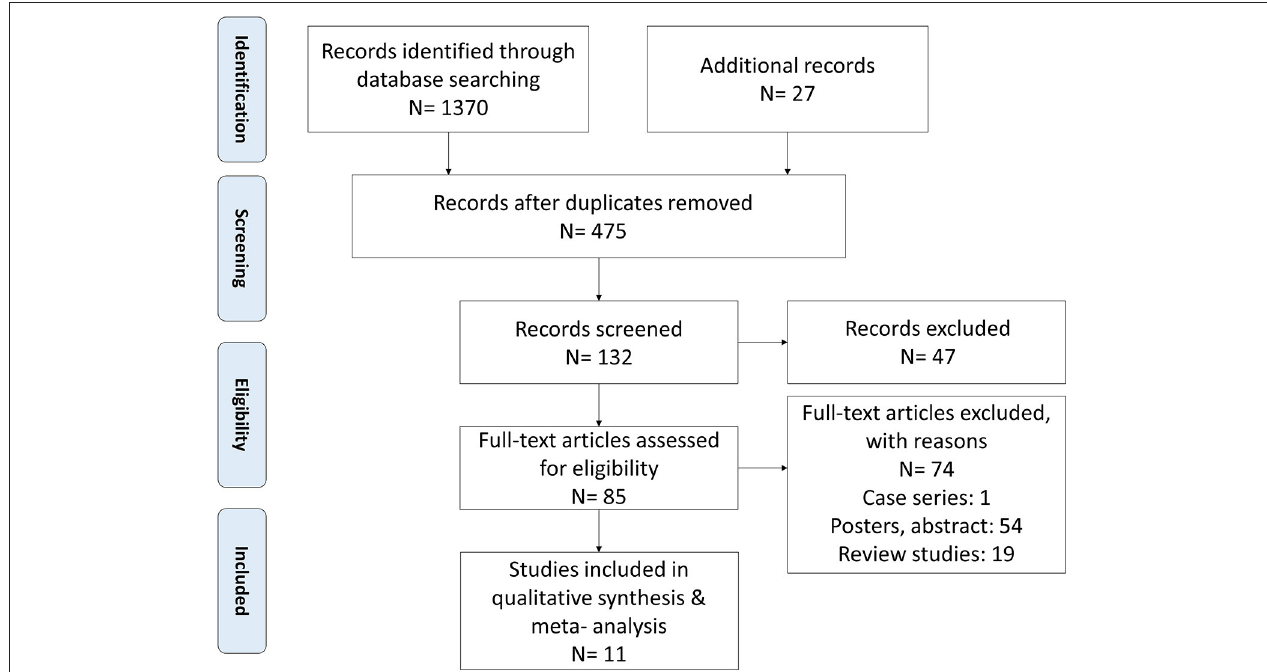
FIGURE 1 | The PRISMA